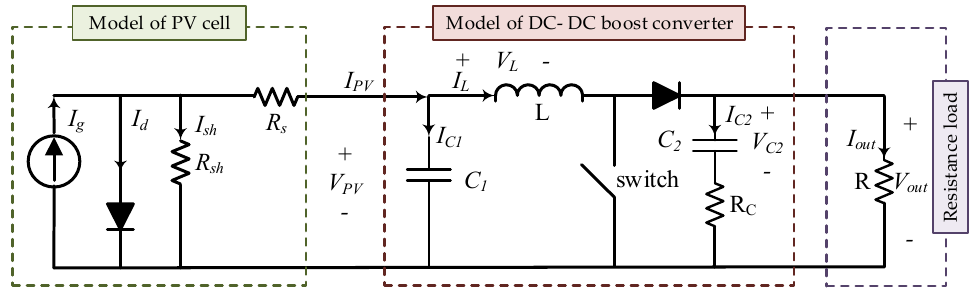
Figure 1. Test system of this paper.